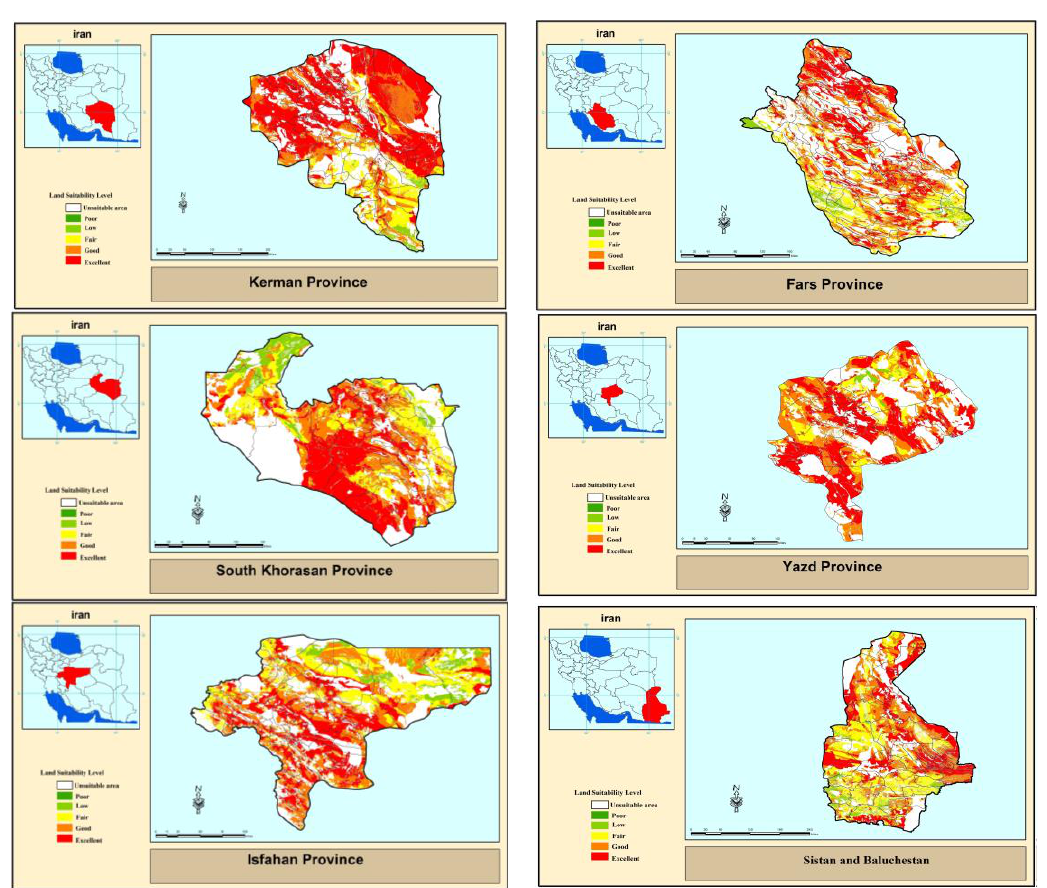
Figure 9. Closer view of the geographical location and classification in the most suitable provinces.